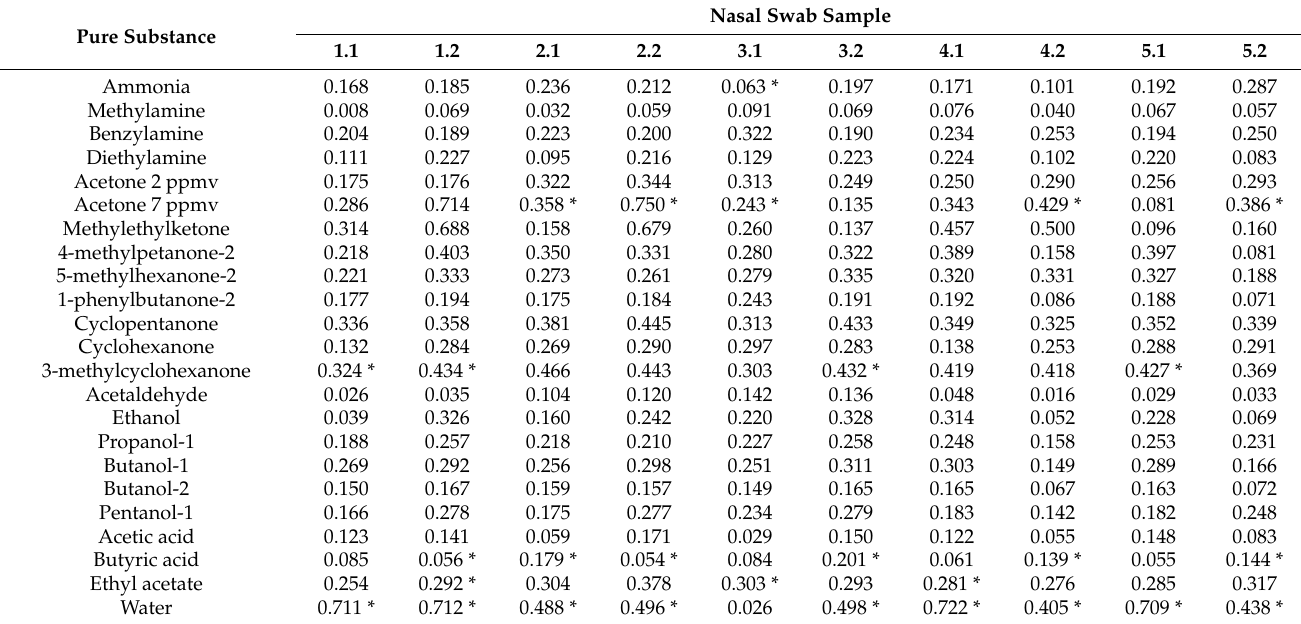
Table 4. The similarity parameter δ for cross mass-sensitivity spectra of nasal swabs samples and individual pure substances. Pure